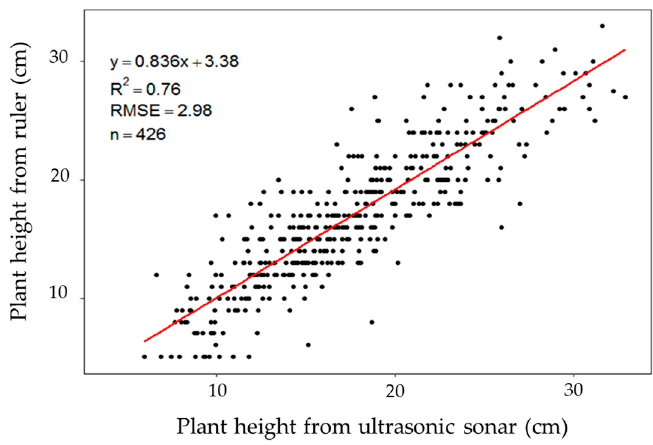
Figure 5. Scatterplots of plant height from ultrasonic sonar sensors vs. manually measured plant height using a standard ruler for the selected measurement date of 19 June 2018.